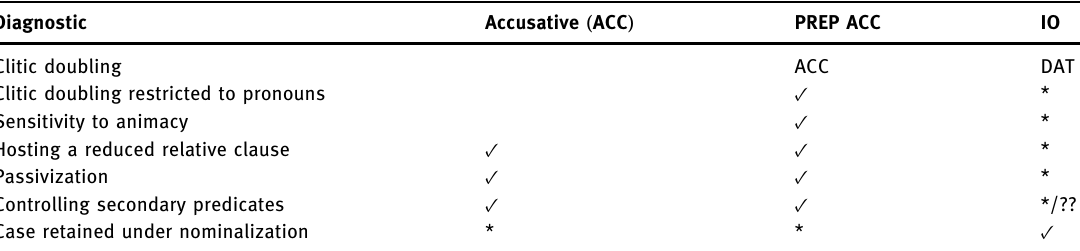
Table 7: Prepositional ACC and IOs in standard Spanish Diagnostic